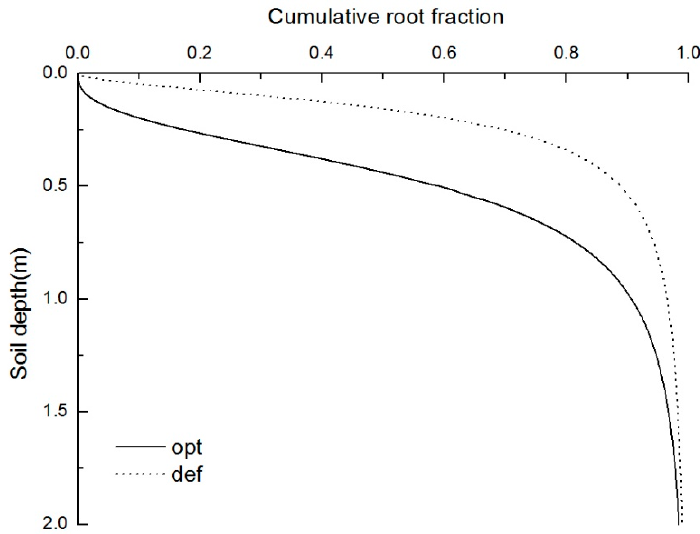
Figure 4. Vertical distribution profiles of accumulated root fraction based on the default (def) and optimized (opt) root distribution parameters.